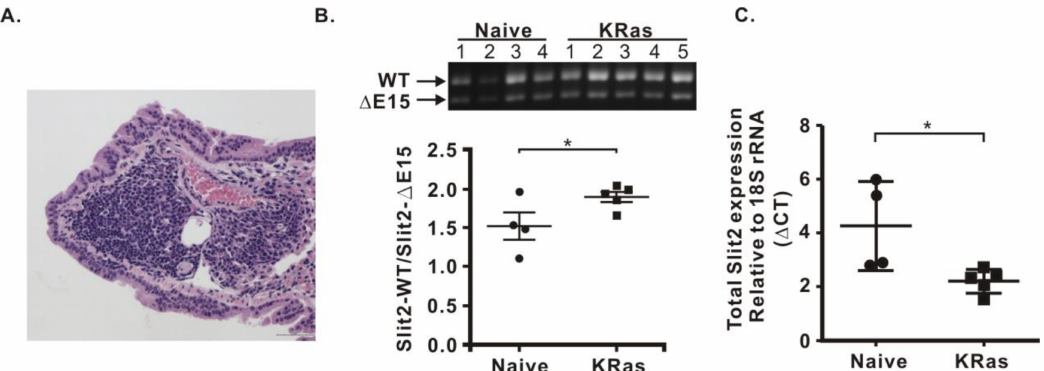
Figure 5. Expressions of Slit2-exon15 isoforms in a kRas G12D -induced lung tumor model. ( A ) Representative figure shows that kRas G12D successfully induced lung tumors. ( B ) The ratio of Slit2-WT/Slit2- ∆ E15 is higher in the lungs with the kRas induction. ( C ) The expression of the total Slit2 is reduced in the lungs with the kRas induction. ( ∆ CT = CT slit2 − CT 18SrRNA ; CT: cycle threshold). Higher ∆ CT means a lower expression of Slit2. * p <